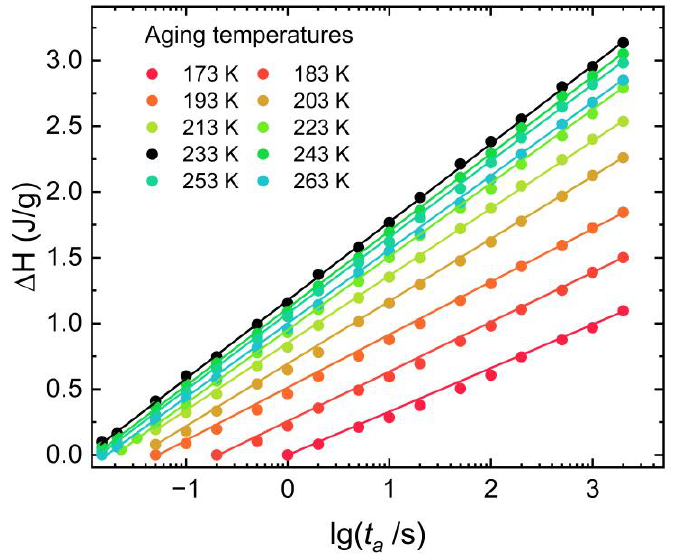
Figure 4. ∆𝐻 values at different aging temperatures of PBTTT. Figure 4. ∆ H values at different aging temperatures of